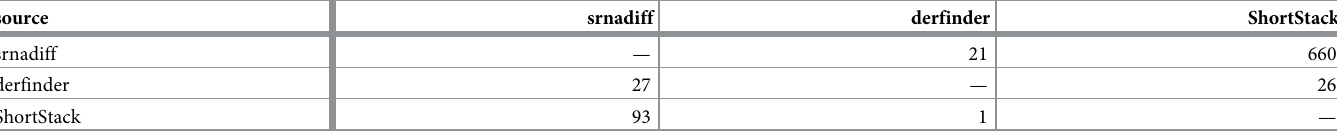
Table 1. Comparison of the results given by the srnadiff, derfinder, and ShortStack methods. Each cell gives the number of elements found by the tool mentioned in row name that overlap with a region found by the tool mentioned in column name. For instance, 660 regions found by srnadiff overlap with the regions found by Short- Stack. Note that only 93 regions found by ShortStack overlap with regions found by srnadiff. Indeed, ShortStack tend to produce longer regions, and one ShortStack region may overlap several srnadiff